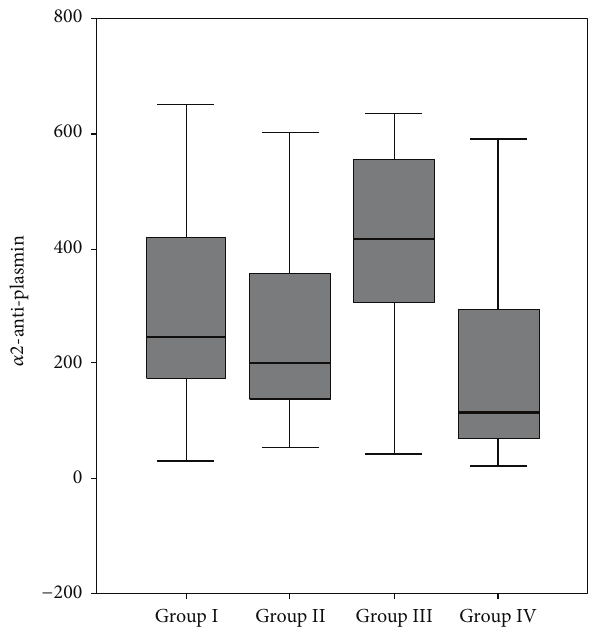
Figure 2: Expression of 𝛼 2-anti-plasmin in the diabetic and control